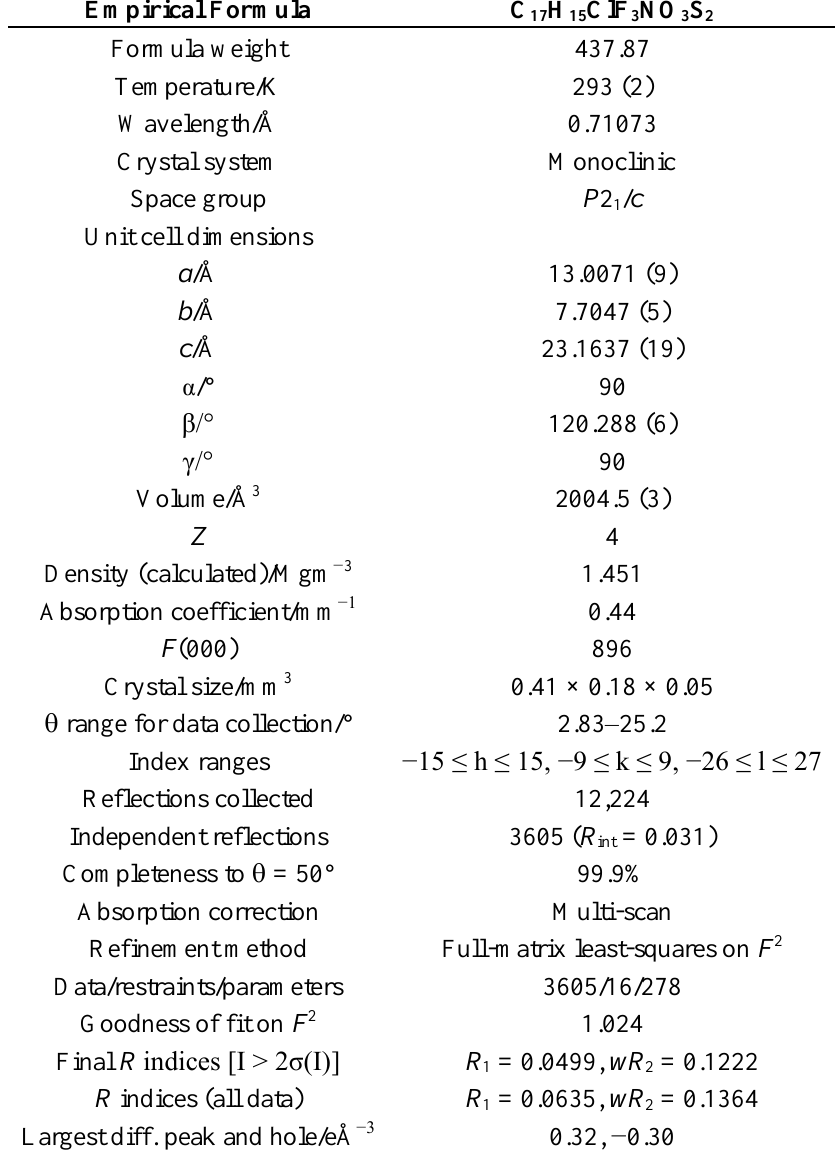
Table 2. Crystal data and structure refinement details for 22